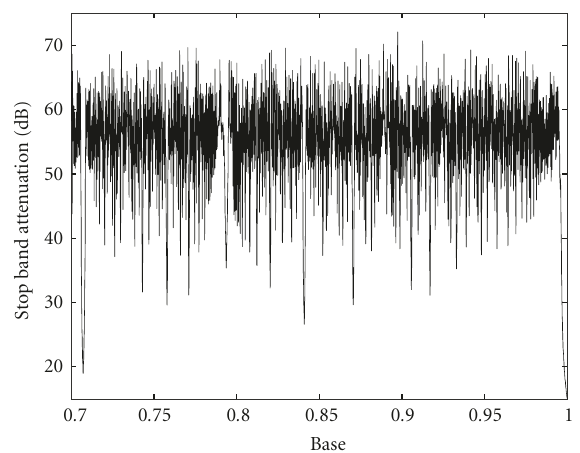
Figure 6: Stop band attenuation for bases 0.7071 to 1.0000 for r c = 63; worst case is 15.0285 dB, best case is 72.0858 dB.